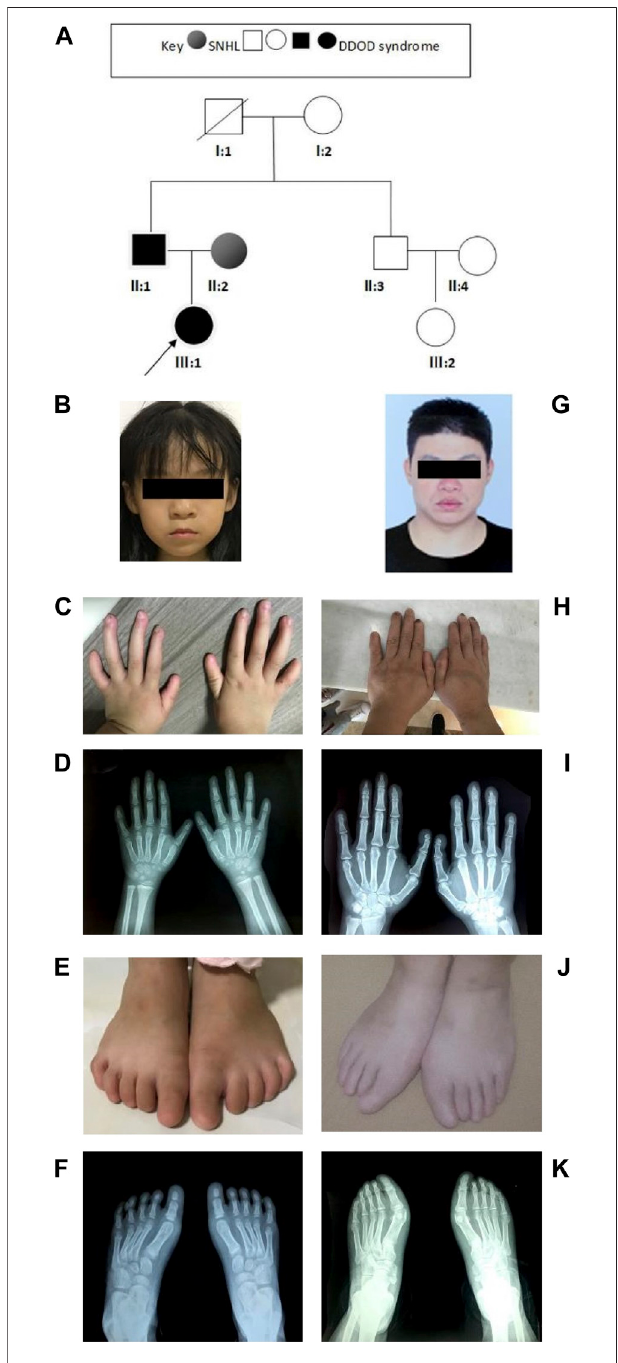
FIGURE 2 | Clinical fi ndings of family 2. (A) Family tree. (B – F) Proband and onychodystrophy. Absent fi ngernails on the fi rst- and fi fth-digits hypoplastic fi ngernails.Toenailsaretotallyabsent.HandandfootX-raysshow normalphalanx development. (G – K) Phenotypes ofonychodystrophyof the father are similar to the